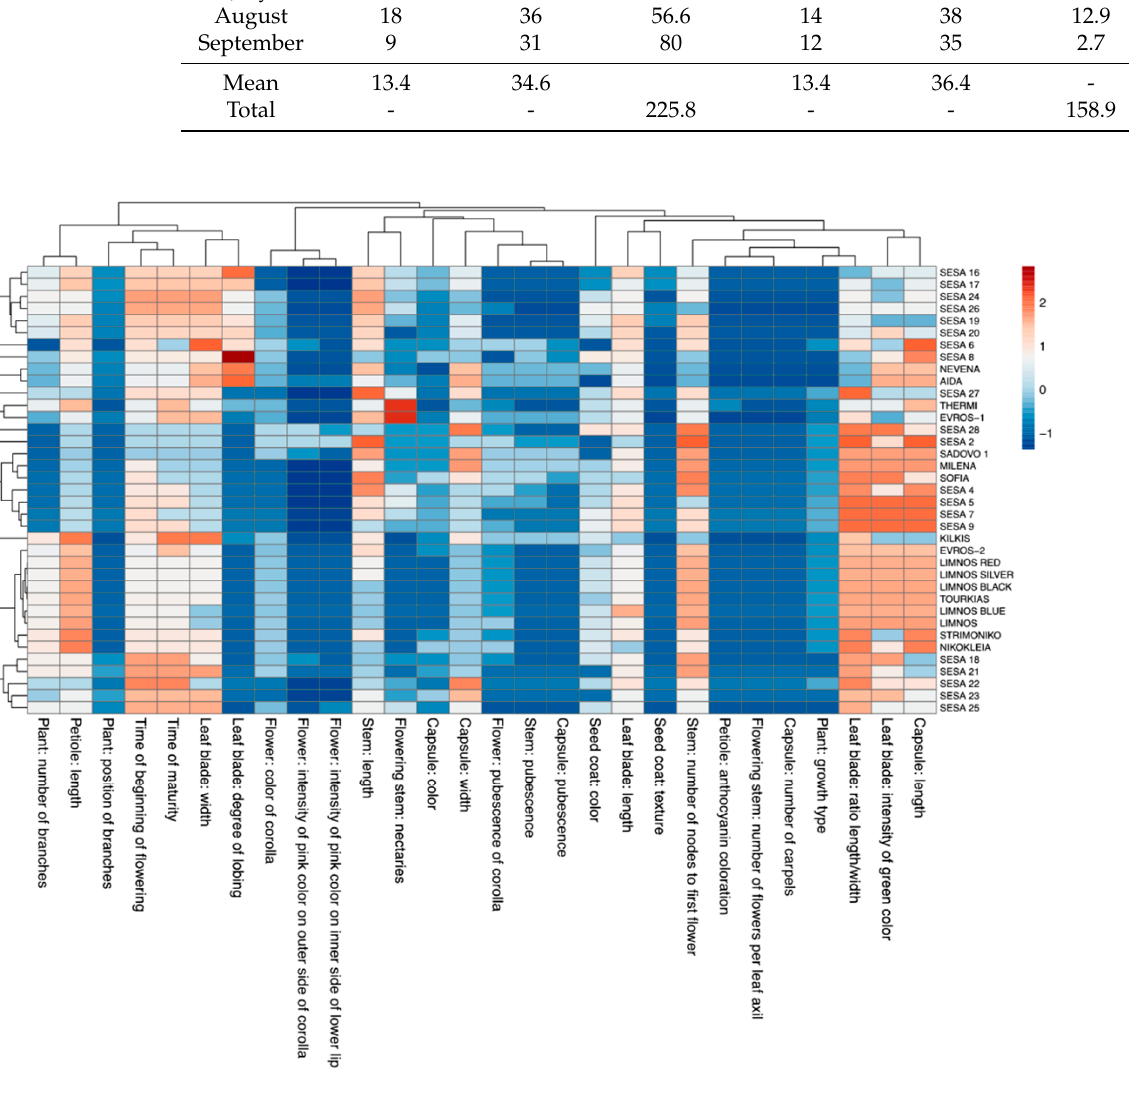
Figure 1. Heatmap of the 28 morpho-physiological descriptors for each of the 37 sesame cultivars. A hierarchical clustering heatmap was performed on log-transformed qualitative data. The color-coded scale indicates an increase (red) and a decrease (blue).